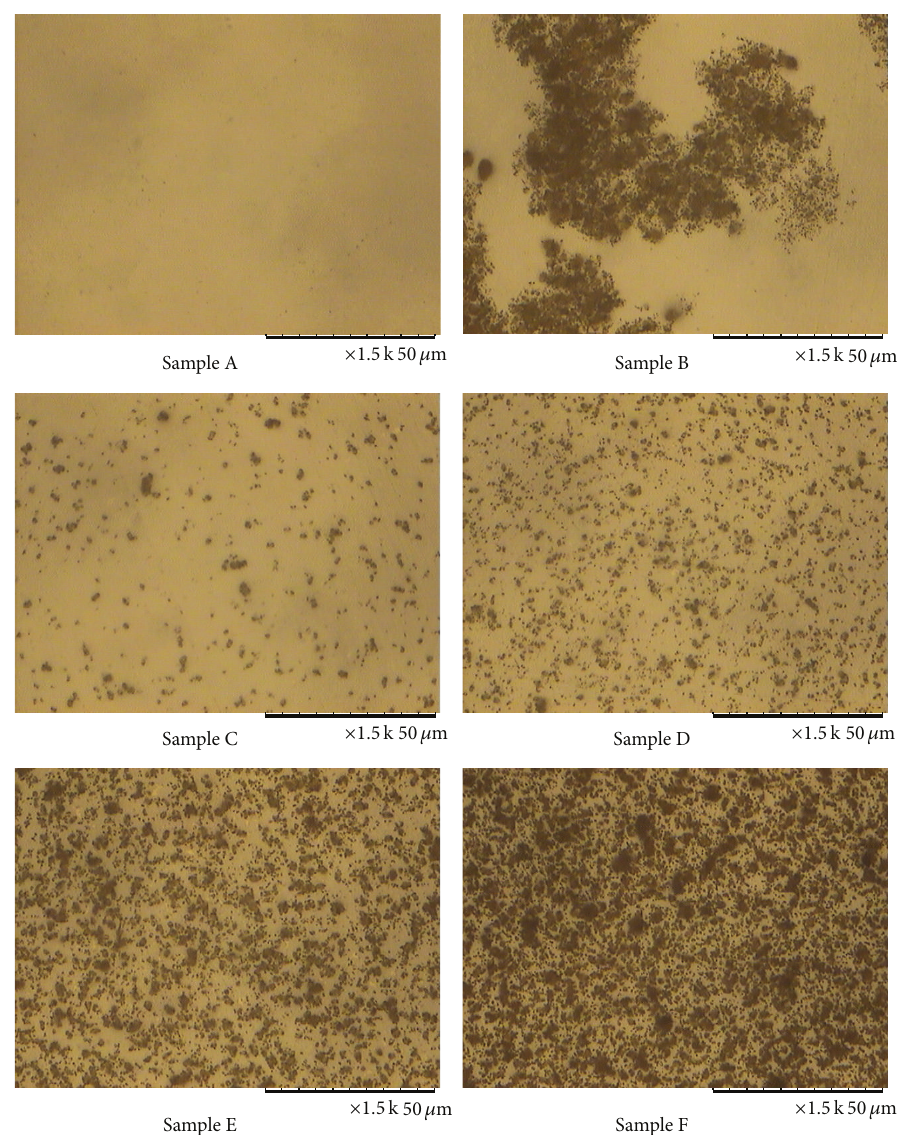
Figure 6: 1500x magnification of metallographic